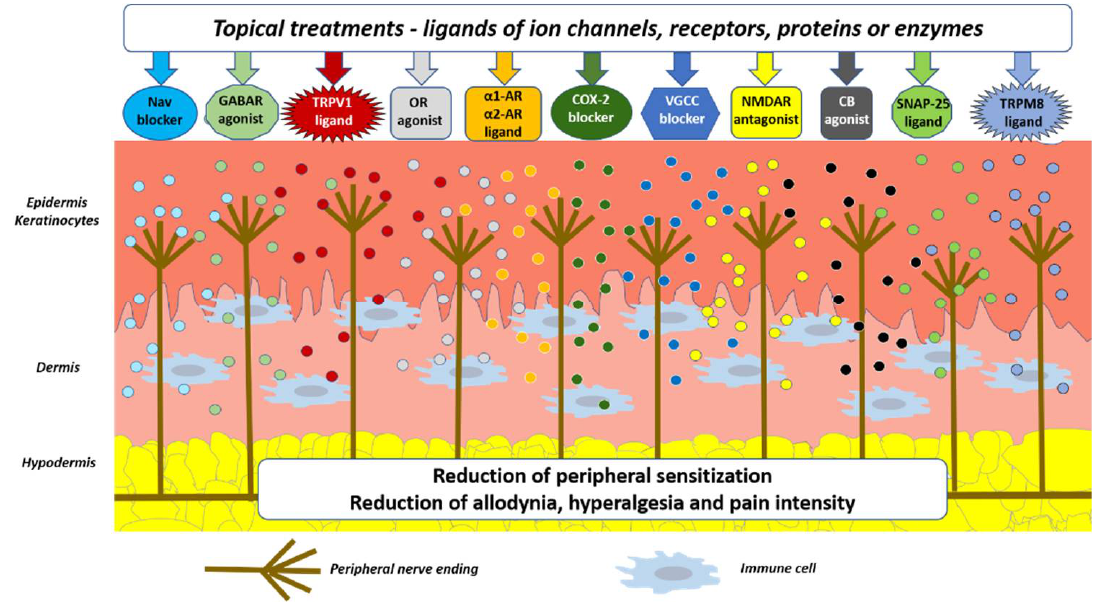
Figure 2. Topical treatments utilized in clinical practice and their molecular/cellular mechanisms in patients suffering from localized NP (LNP). Active molecules from topically applied drug formulations modulate the corresponding ion channels, receptors, enzymes, or proteins on neuronal and non-neuronal cells. Abbreviations: Nav—voltage-gated sodium channels, TRPV1—transient receptor potential vanilloid 1, VGCCs—voltage-gated calcium channels, NMDAR—N-methyl-D-aspartate receptors, α1-AR—α1 adreno receptors, α2-AR—α2 adreno receptors, GABAR—gamma-aminobutyric acid receptors, CB—cannabinoid receptors, COX-2—cyclooxygenase 2, SNAP-25— synaptosome associated protein 25, OR—opioid receptors, TRPM8—transient receptor potential melastatin 8.